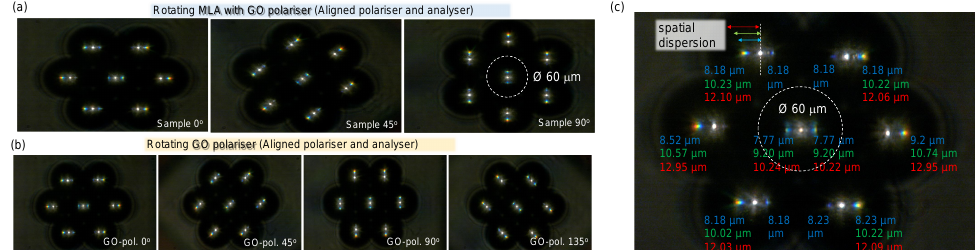
Figure 5. Optical microscopy imaging in the visible spectral range under white light condenser illumination. ( a ) The MLA and GO-polariser are fixed together and azimuthally rotated by the θ - angle with respect to the aligned polariser–analyser (high-transmittance mode). ( b ) The MLA is fixed and the GO-polariser is θ -rotated around the optical axis and aligned with the polariser–analyser. ( c ) RGB colour dispersion at the focal region measured by the optical microscope; the colour indicates the distances between the dispersed RGB colours and the focal spot centres. Substrates for the MLA and GO-polariser were 1-mm-thick CaF 2 . The NA of the imaging lens (Nikon Microscope TU Plan Fluor, 50 × ) was